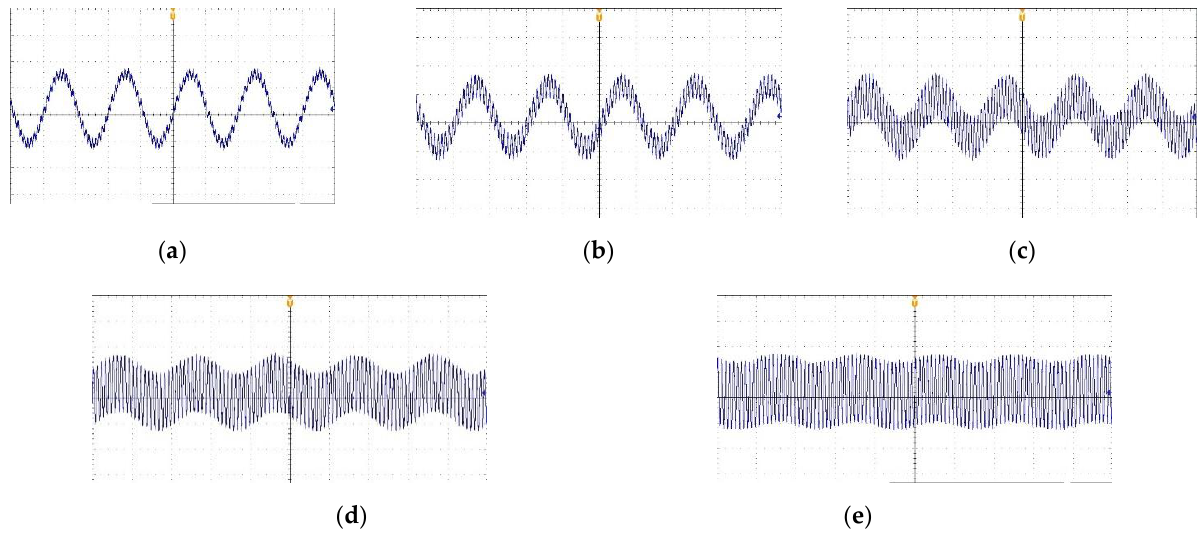
Figure 8. Example waveforms (time: 10 ms/div) composed of two frequencies, generated by the laboratory generator: ( a ) 50 Hz (90%) and 1000 Hz (10%); ( b ) 50 Hz (75%) and 1000 Hz (25%); ( c ) 50 Hz (50%) and 1000 Hz (50%); ( d ) 50 Hz (25%) and 1000 Hz (75%); ( e ) 50 Hz (10%) and 1000 Hz (90%).